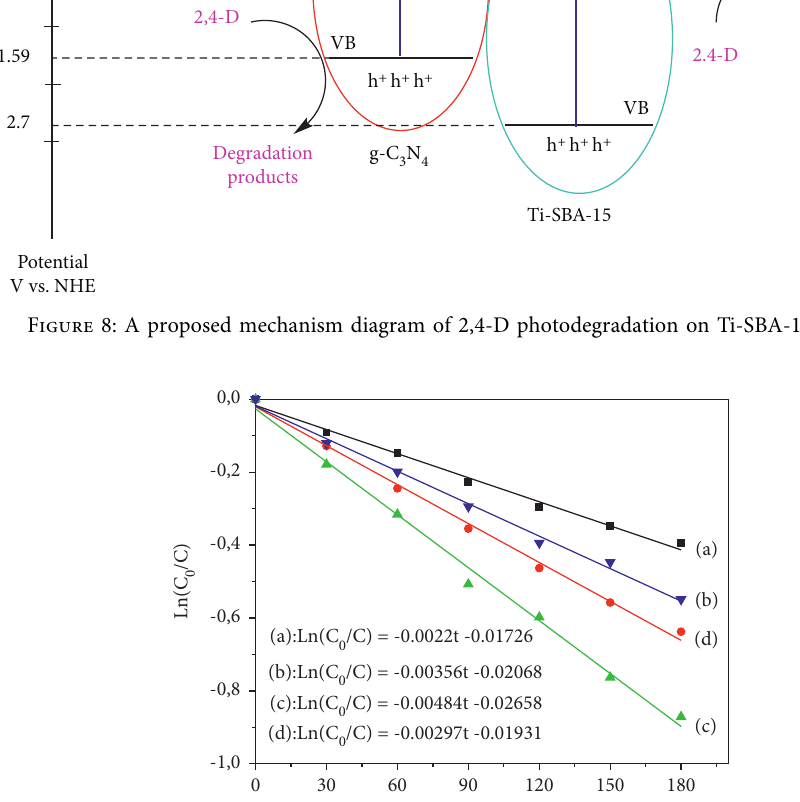
3 N 4 ; (b):1Ti-SBA-15/C 3 N 4 ; (c): 2.5Ti-SBA-15/C 3 N 4 ; (d):